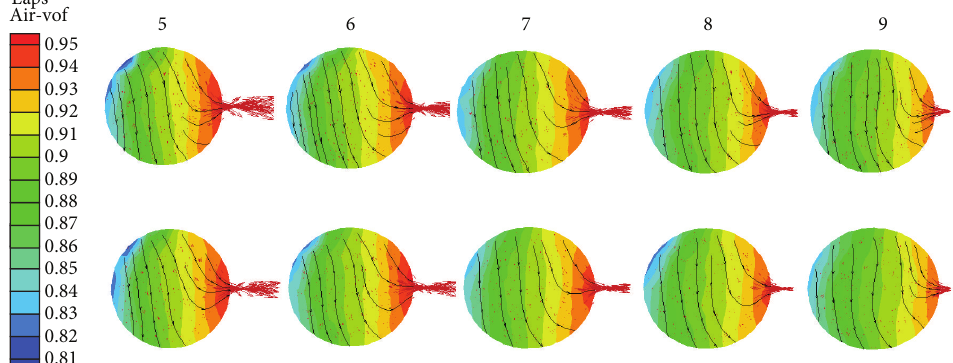
Figure 14: The flow field and contour of gas void fraction on different sections at laps.